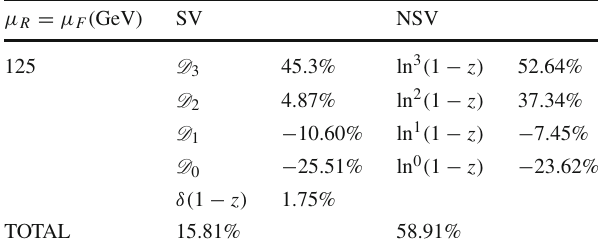
Table 3 % contribution of SV distributions and NSV logarithms to the Born cross section at NNLO at μ R = μ F = 125 GeV in z -space